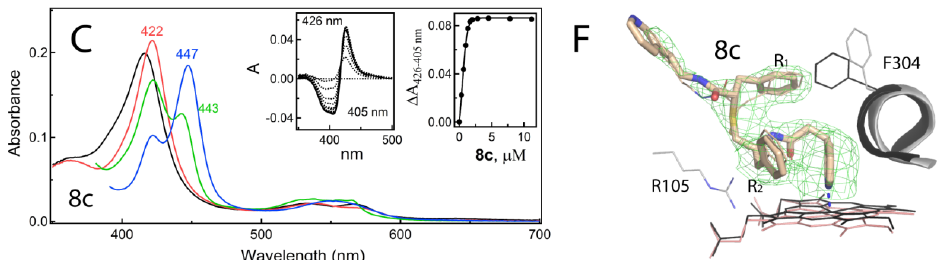
Figure 5. Spectral properties and the binding modes of 8a − c . ( A − C ) Ligand-induced spectral changes in CYP3A4. Absorbance spectra of ferric ligand-free and inhibitor-bound CYP3A4 are in black and red, respectively. Spectra of ferrous ligand-bound CYP3A4 and its CO-adduct are in green and blue, respectively. Left insets are difference spectra recorded during equilibrium titrations; right insets are titration plots with quadratic fittings. The derived K s values are given in Table 1. ( D − F ) Binding modes of 8a − c observed in the crystal structures. The central portion of the I-helix and Phe304 in the inhibitory complexes and water-bound CYP3A4 (5VCC structure) are depicted in gray and black, respectively. 8a and 8c bind in a reverse mode, with the end-pyridine serving as the heme-ligating moiety. However, the R 1 - and R 2 -phenyl groups (indicated) occupy the same sites. Polder omit electron density maps contoured at 3 σ level are shown as green mesh. The 8a -, 8b -, and 8c -bound structures of CYP3A4 have the PDB ID codes 7UFB, 7UFC, and 7UFD, respectively.